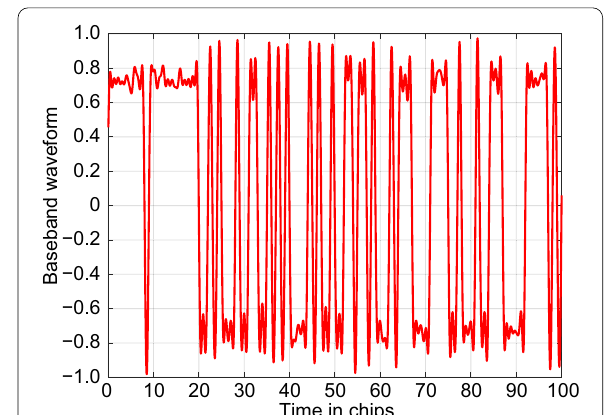
Fig. 17 Baseband waveform of BDS-3 GEO-1 PPP-B2b_I